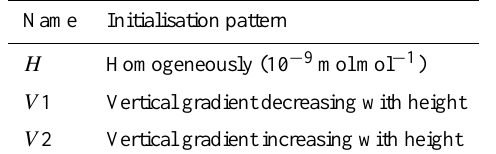
Table 3. Table of passive tracers for the transport test with PTRAC. X is a placeholder for either H , V 1 or V 2 and refers to the initiali- sation patterns (Tab.